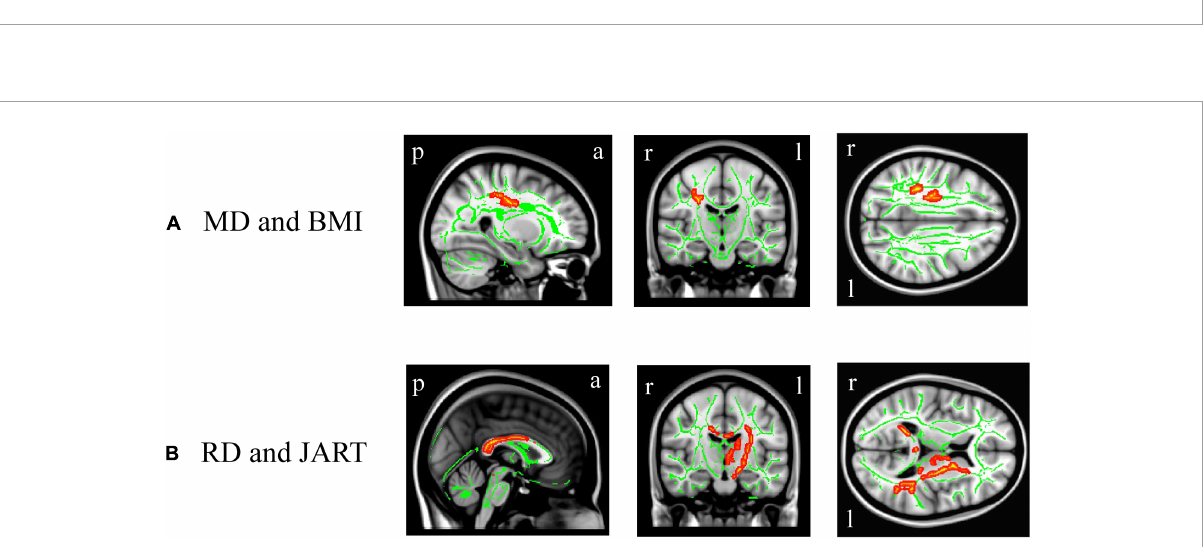
FIGURE5 White matter regions where the mean diffusivity (MD) and radial diffusivity (RD) values were correlated with body mass index (BMI) and Japanese Adult Reading Test (JART) score, respectively. BMI was significantly and positively correlated with the right superior longitudinal fasciculus MD value (A , p < 0.05 corrected ) , while the JART score significantly and negatively correlated with the corpus callosum and left internal capsule RD value (B , p < 0.05 corrected). Images coordinate x = 27.0 mm, y = − 17.0 mm, z = 34.0 mm (A) and x = 0.0 mm, y = − 15.0 mm, z = 10.0 mm (B) , respectively, in the Montreal Neurological Institute 152 T1 atlas. a, anterior; l, left; p, posterior; r,